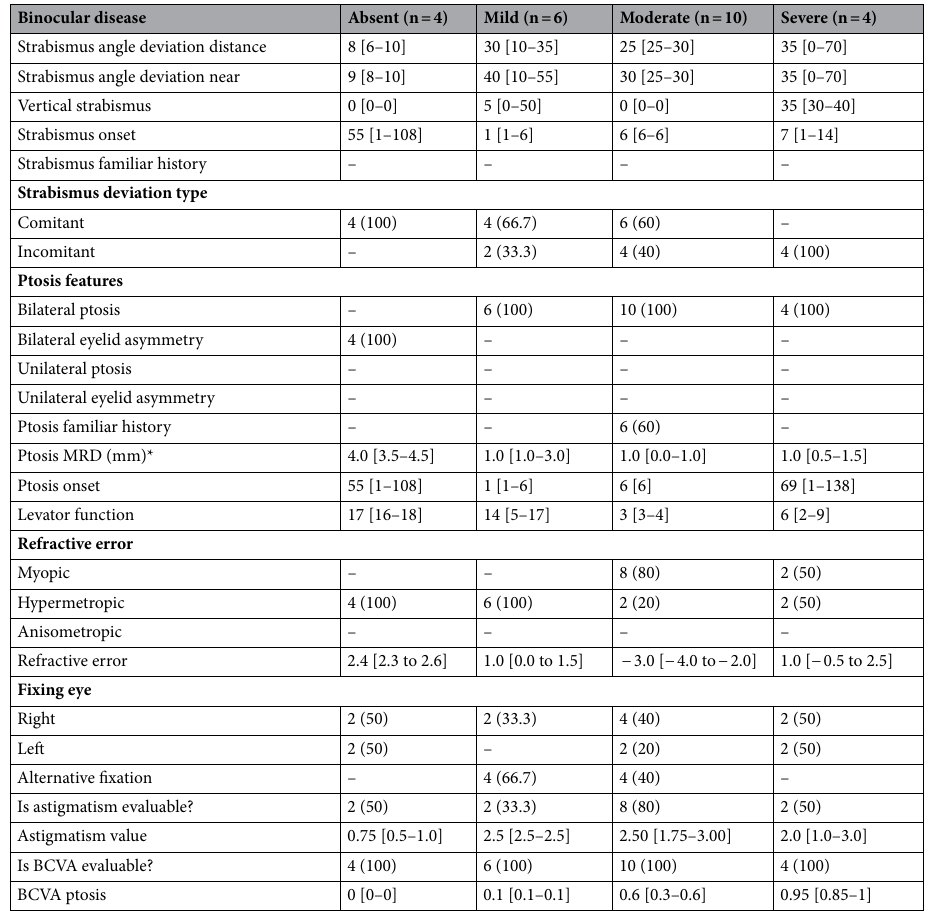
Table 6. Association between amblyopia and general and clinical characteristics in the study cohort according to patients’ subgroups. Amblyopia was analysed on the subgroup of patients for which information was available. Qualitative variables are expressed as absolute and percentage frequency quantitative data as median and interquartile range (IQR). M male, F female, MRD margin reflex distance, BCVA best corrected visual acuity. *Others: congenital cranial dysinnervation disorders Genetic CNS disorders/neurological diseases ocular syndromes/orbital